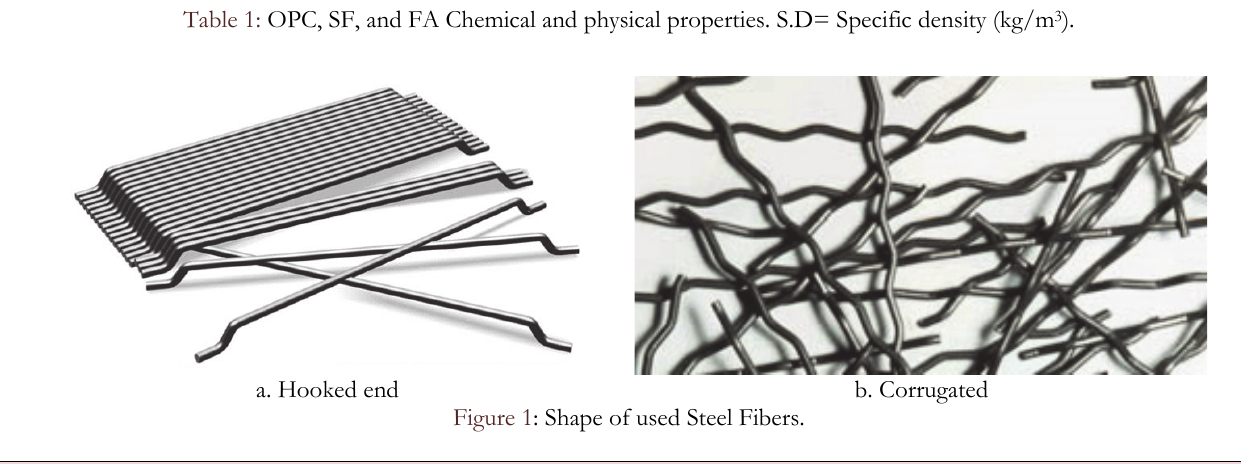
Figure 1: Shape of used Steel Fibers.